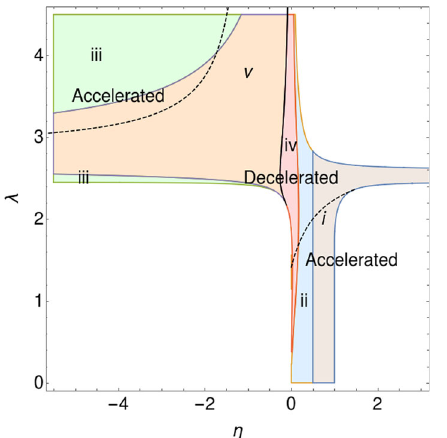
Fig. 7 Part of the region of existence of solution for the critical point K + when α = − β ≡ η . The region labeled by i contains saddle points and iii unstable points